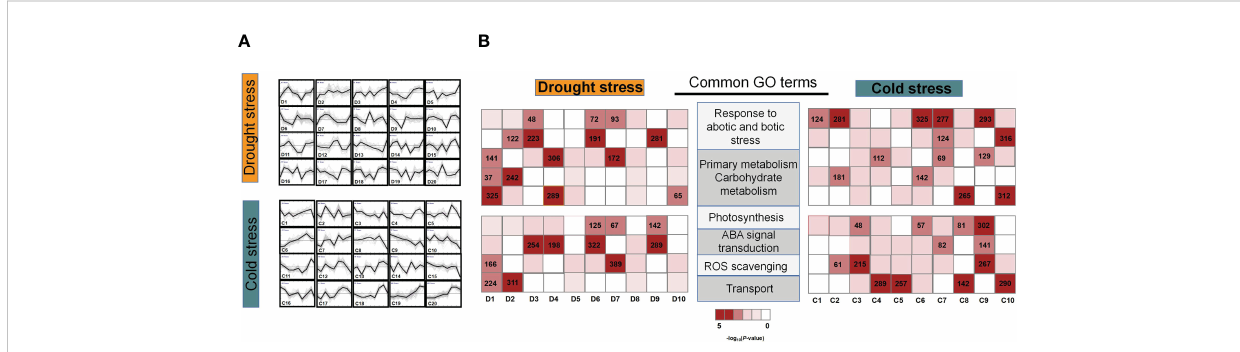
FIGURE 3 Temporal dynamics of M. rubra transcriptome during drought and cold treatment. (A) Expression dynamics of the 20 largest gene clusters over time under drought (D1 – D20) and cold stress (C1 – C20). (B) GO terms enriched in DEGs, with red indicating more signi fi cant enrichment ( – log10( P - value)). The heatmaps show enriched GO terms detected in temporally dynamic groups of both drought and cold stress from 1 to 48